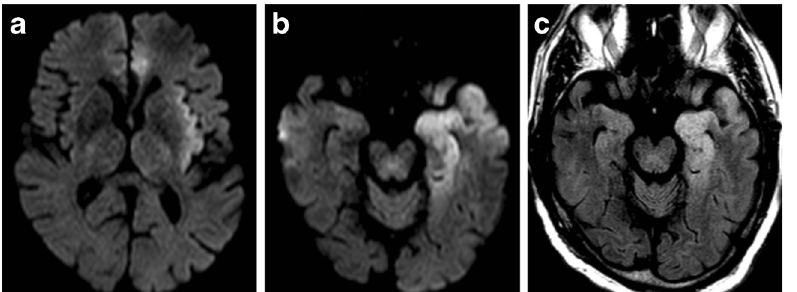
Fig. 8 Herpes simplex virus encephalopathy. Seventy-one-year-old man with fever and encephalopathy. DWI demonstrates cortical increased signal within the left anterior cingulate and left insula ( a ) and the left